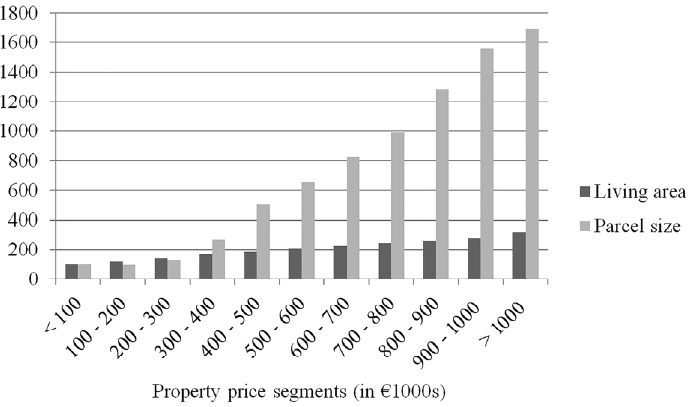
Figure 2. Index of mean floor area and mean parcel size by property price segment (the index-base is set at 100 in regard to the segment of properties with prices below €100,000).